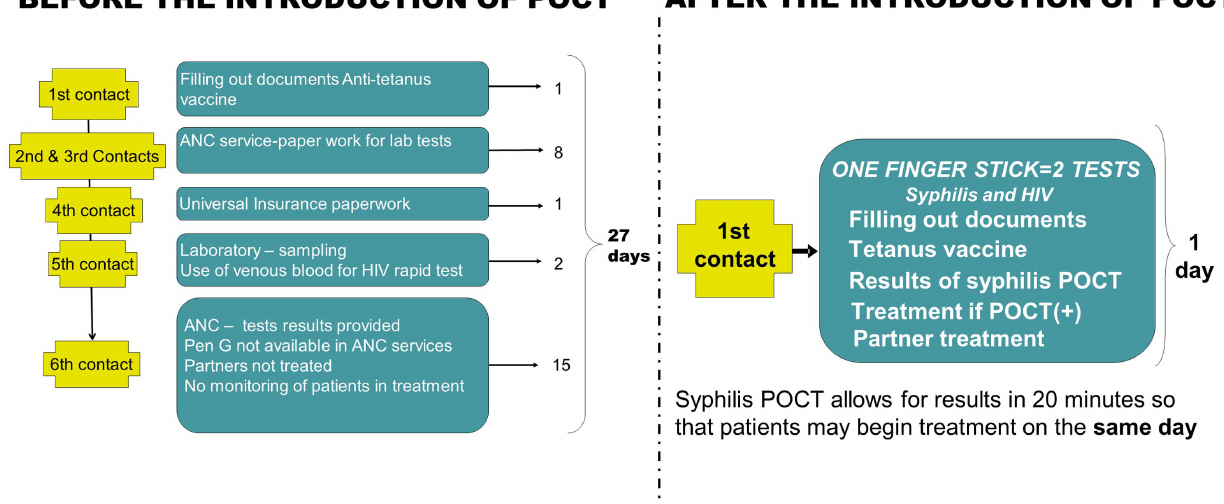
Figure 2. First antenatal care visit: Changes before and after the implementation of POCT for syphilis (Ventanilla-Callao). Before the implementation of the POCT for syphilis, women needed 27 days to have the HIV and Syphilis tests results as part of the first antenatal care visit (ANC) visit. After the implementation, the testing and results are done on the same visit.